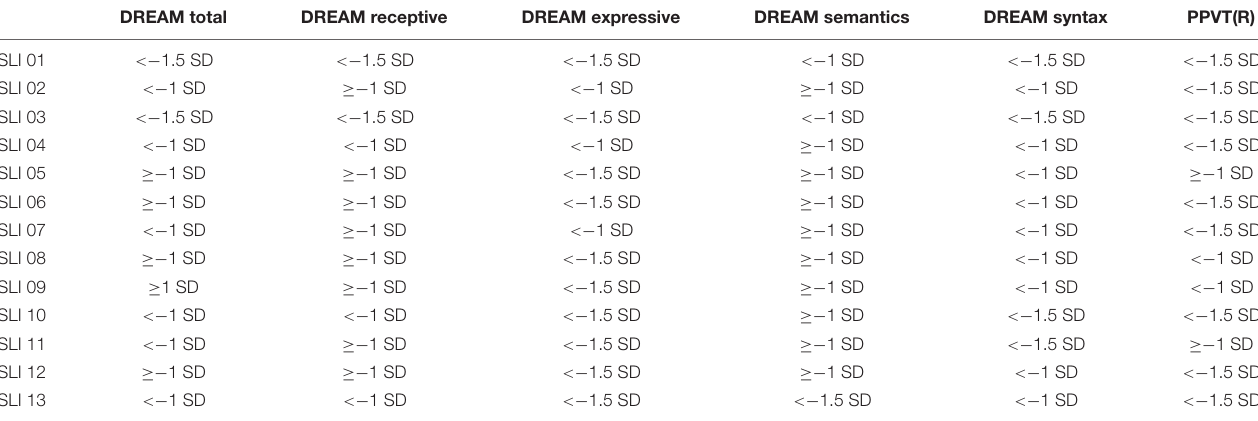
TABLE 1 | Test scores of the children with SLI. DREAM total DREAM receptive DREAM expressive DREAM semantics DREAM